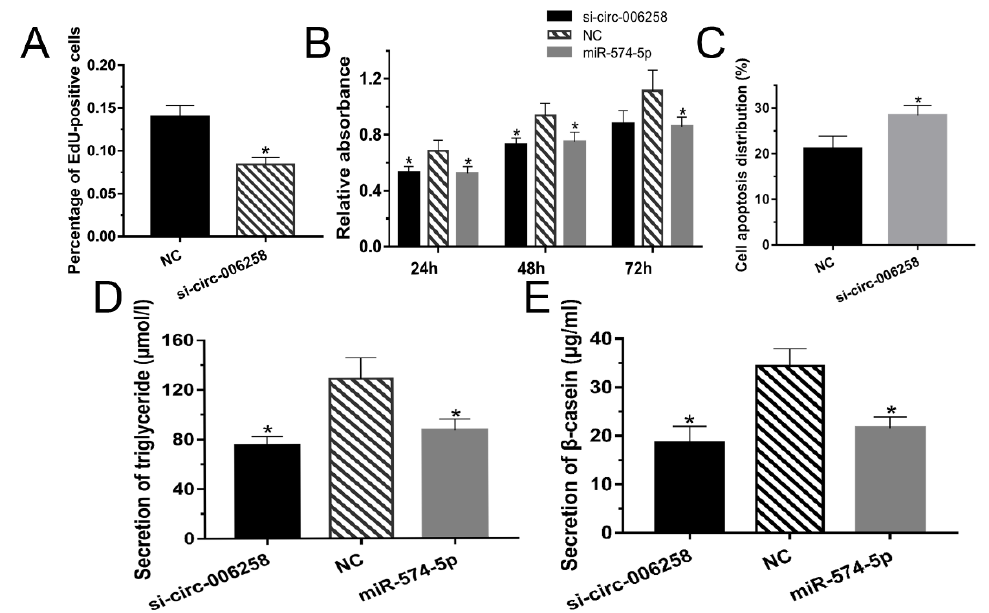
Figure 6. CircRNA-006258 promoted GMEC growth. ( A ) EdU was used to analyze the cell proliferation when the GMECs were cultured for about 24 h after transfection. ( B ) Cell viability of the GMECs was determined by CCK-8 when the cells were cultured for 24, 48, and 72 h after transfection. ( C ) Flow cytometry was performed to analyze cell apoptosis after transfecting for about 24 h. ( D ) The secretion of triglycerides in the GMECs was measured with a detection kit. ( E ) The expression of β -casein in the cell-free supernatants by enzyme-linked immunosorbent assay kit. NC: negative control; si-circRNA-006258: small interfering RNA. ** means significant di ff erence ( p < 0.01), * means significant di ff erence ( p < 0.05).